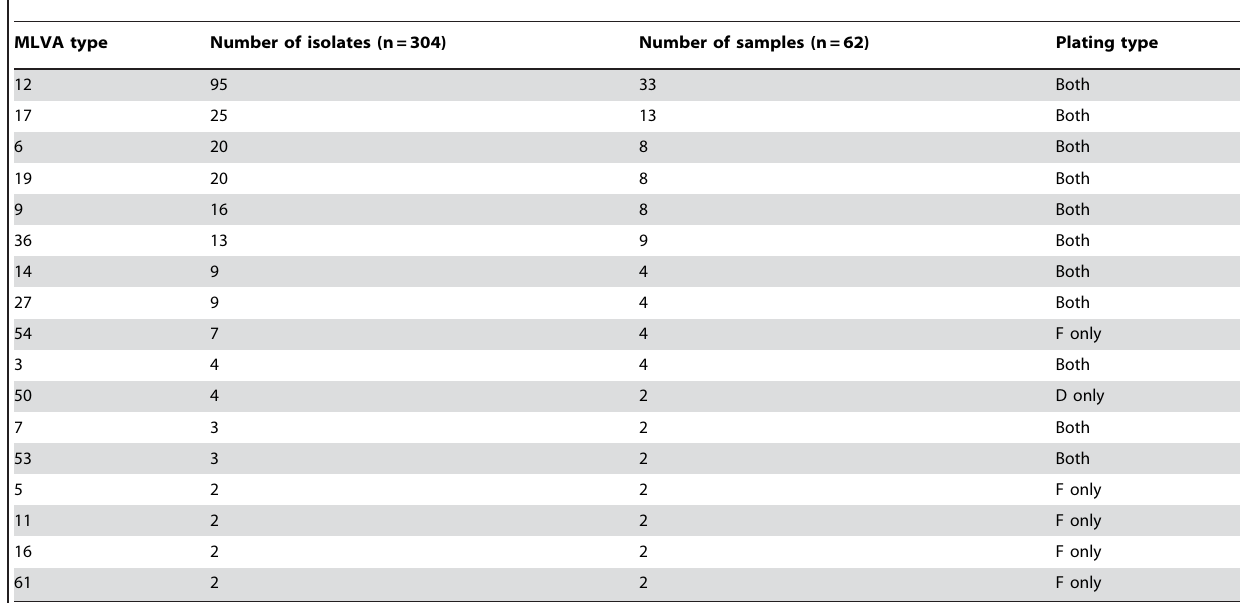
Table 5. MLVA types detected from more than one water sample and enrichment type from which they were isolated.